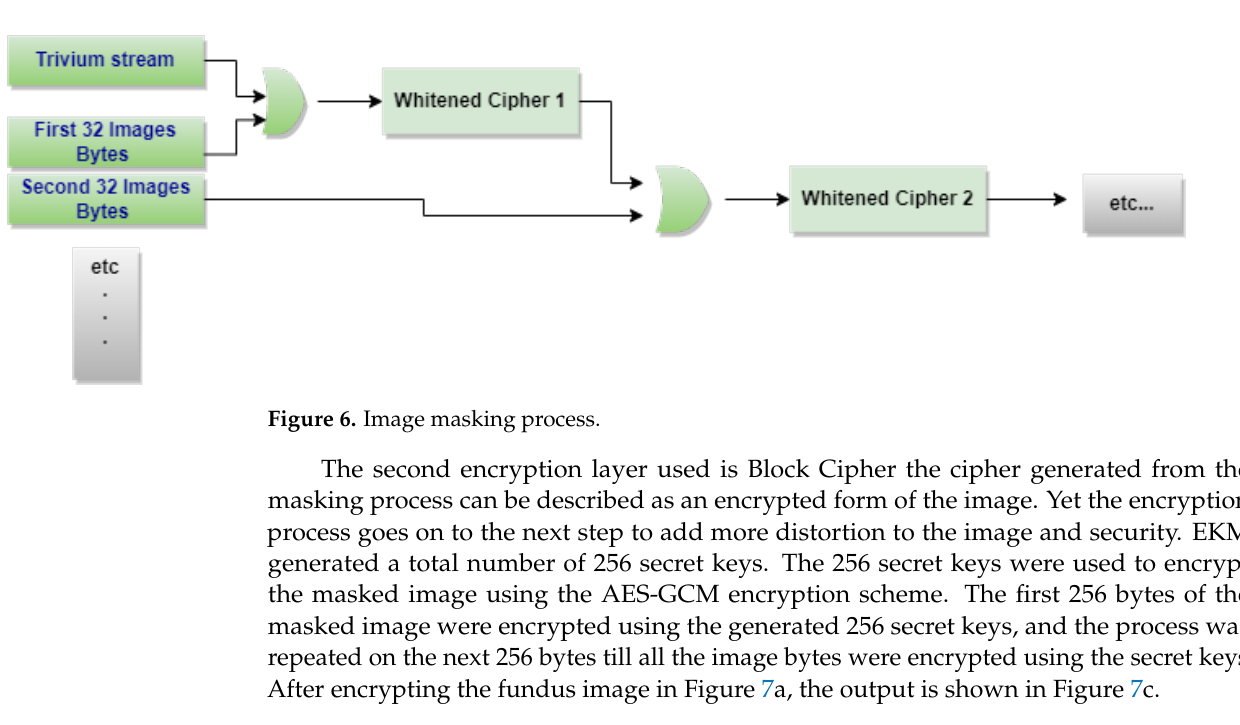
Figure 5. The proposed Algorithm.